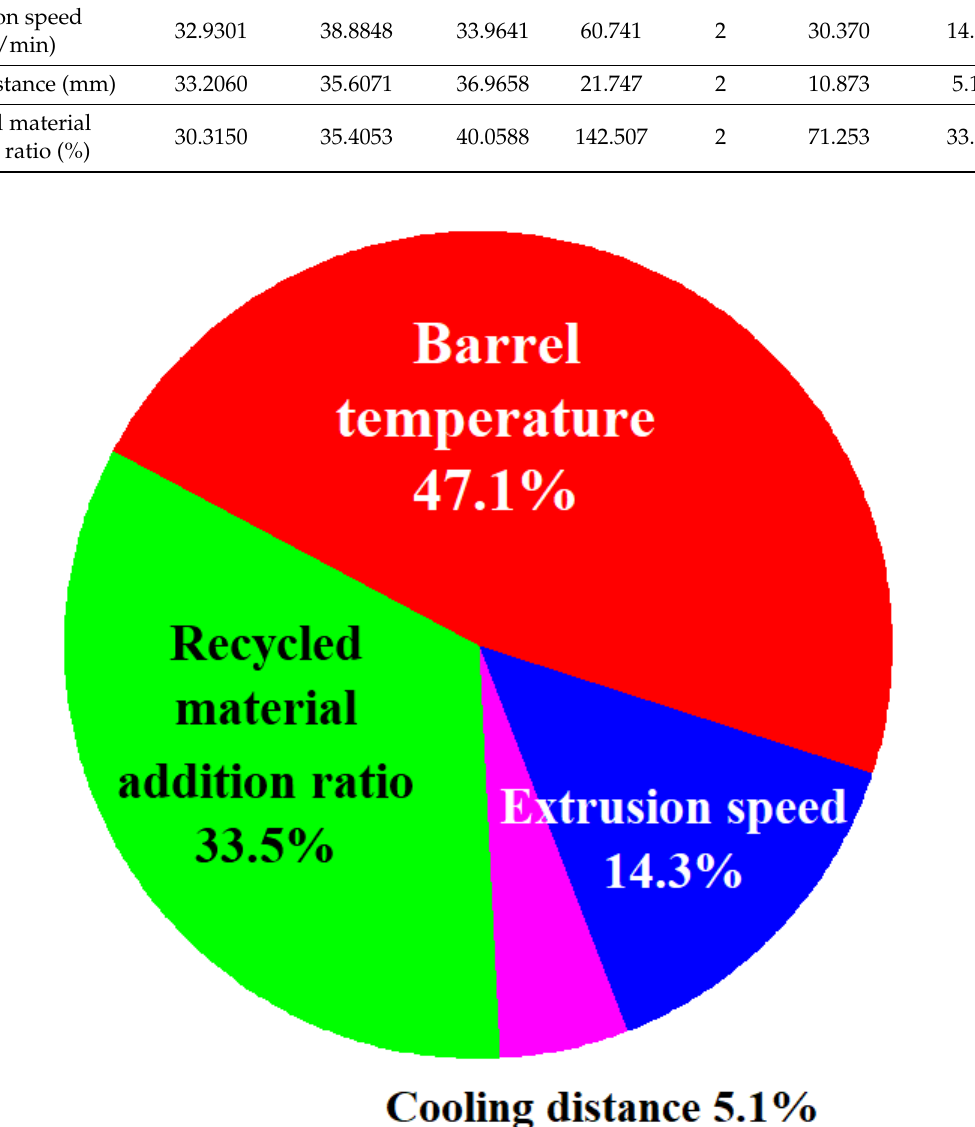
Figure 10. Percentage contributions of the four different control factors The verification experiment is essential in engineering analysis to validate the diameter of the PLA filament fabricated by the optimal process parameters. Thus, the final step of the DOEs is to carry out a verification experiment for examining diameter of the PLA filaments fabricated by both the general process parameters and optimal process parameters. To verify the effectiveness of the optimal process parameters, three sets of general process parameters were employed to manufacture PLA filaments. Table 5 shows the results of verifying the optimal process parameters. Figure 11 shows the results of the verification experiments. The PLA filament diameters fabricated by the optimal process parameters (No. 1 of verification experiments) are 1.7 mm, 1.71 mm, and 1.69 mm, respectively. The average PLA filament diameter is approximately 1.7 mm. The PLA filament diameters fabricated by the first general process parameters (No. 2 of verification experiments) are 1.66 mm, 1.65 mm, and 1.66 mm, respectively. The average PLA filament diameter